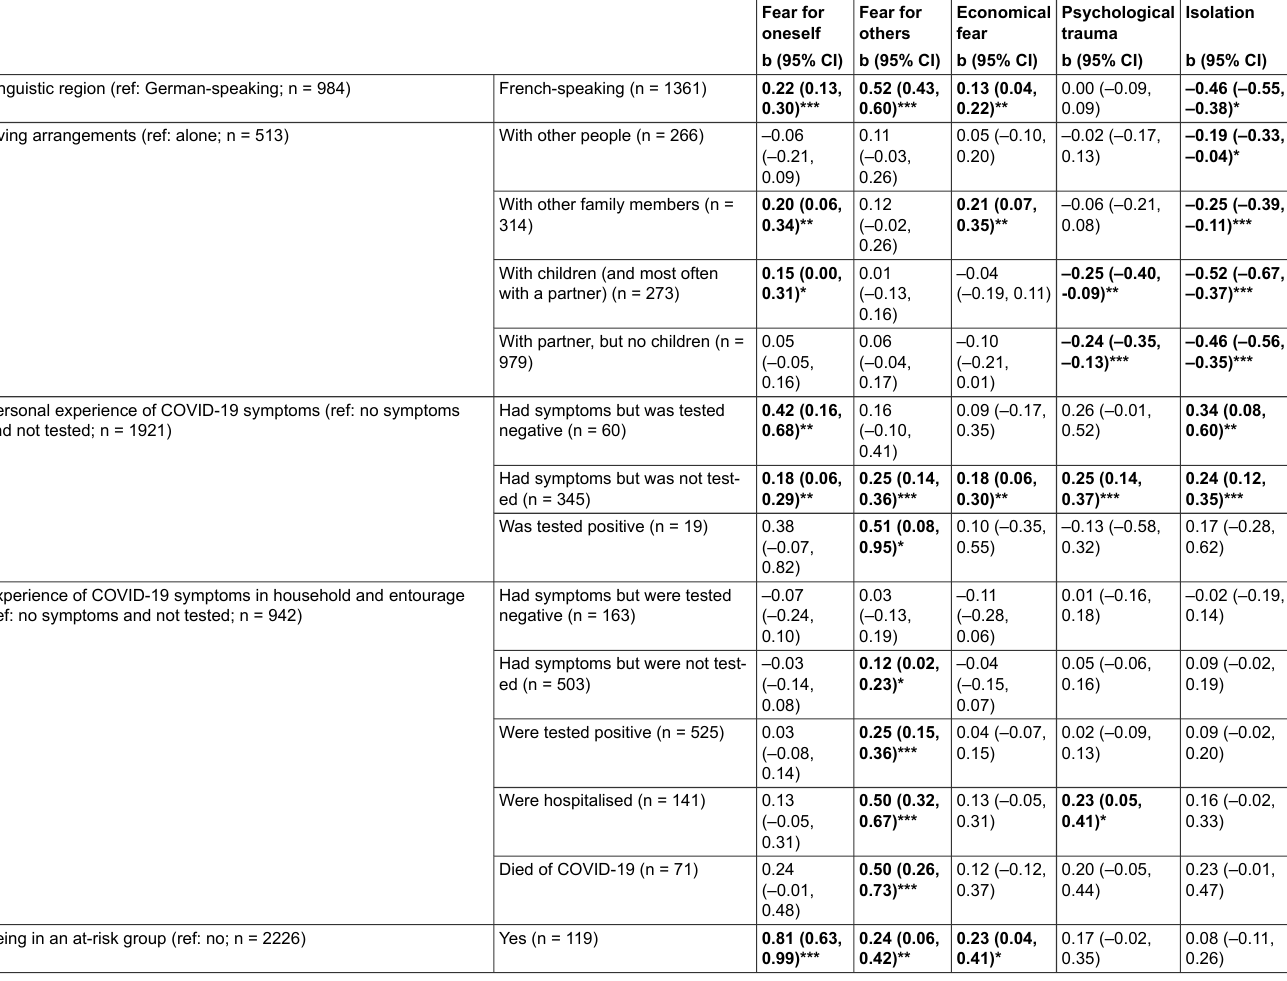
Table 5: Associations of the psychological consequences of the COVID-19 crisis for which it was mentioned as a cause, measured during COVID-19 only, with linguistic region, living arrangements, experiencing COVID-19 symptoms and being in an at-risk group,